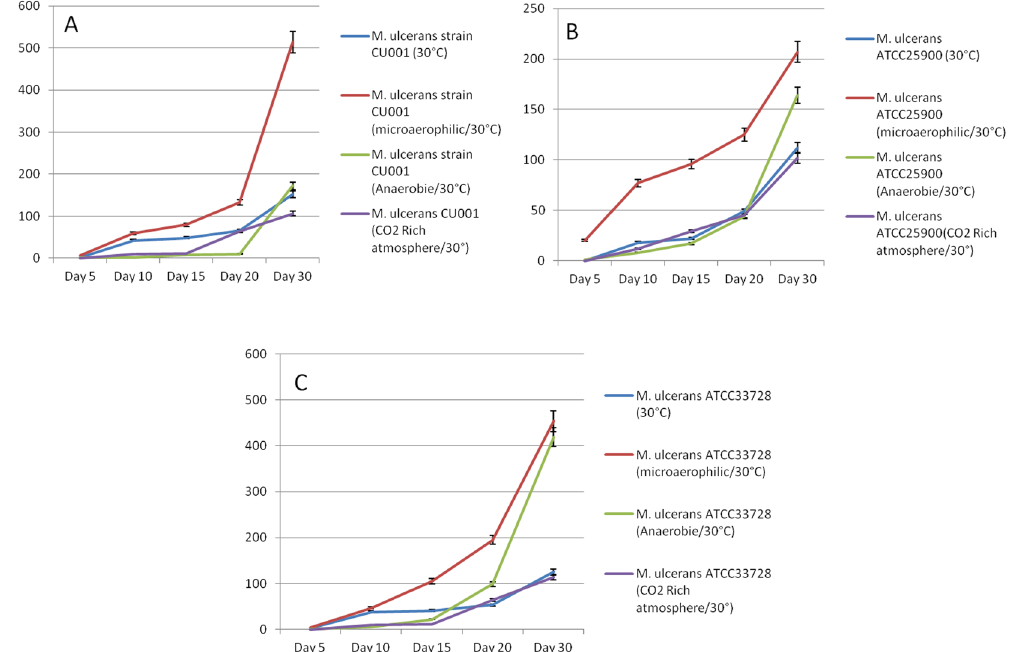
Figure 1. Triplicate culture of 10 4 bacilli of M. ulcerans CU001 ( A ), M. ulcerans ATCC25900 ( B ) and M. ulcerans ATCC33728 ( C ) in Middlebrook 7H10 under different atmospheres (ambient atmosphere, and microaerophilic, anaerobic and 5% CO 2 -enriched atmosphere). Microaerophilic atmosphere yielded the optimal growth of M. ulcerans (red line).